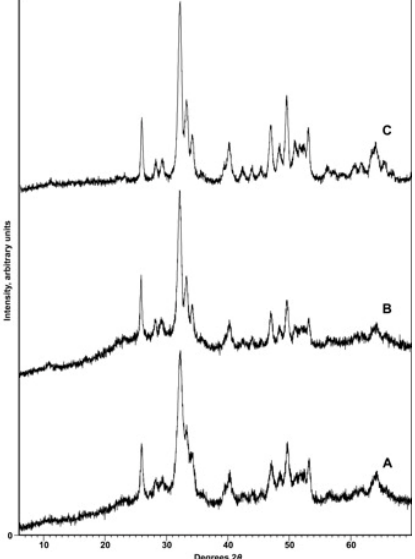
Figure 11. XRD patterns for CCaApF containing 7.6 wt% carbonate; ( A ) after in vacuo drying; ( B ) after dehydration at 550 °C; and ( C ) after rehydration for 4 days at 100